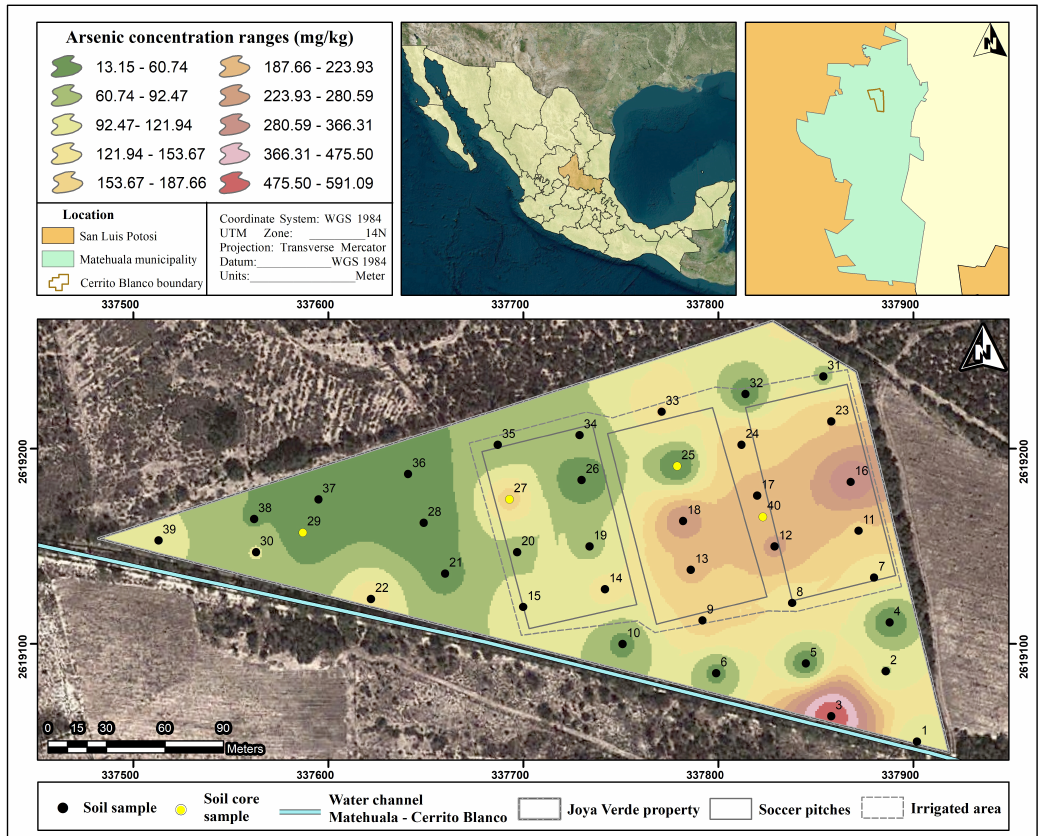
Figure 3. Geochemical map of tAs concentration in the surface soils by inverse distance weighting (IDW). Sampling locations and irrigated and non-irrigated areas are